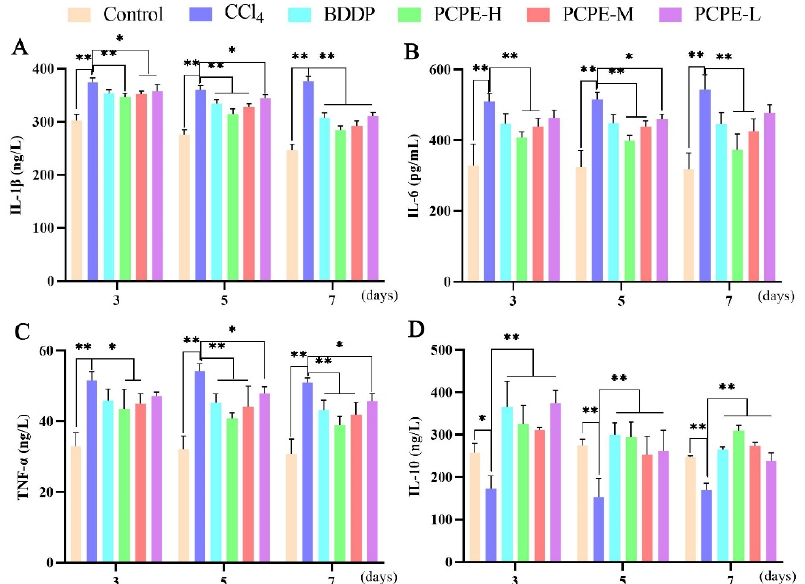
Figure 5. PCPE effects on inflammatory cytokines in dogs with ALI induced by CCl 4 . ( A ) IL-1 β , ( B ) IL-6, ( C ) TNF- α , ( D ) IL-10. Data represented as Means ± SD. * and ** indicates p < 0.05, p < 0.01, respectively.